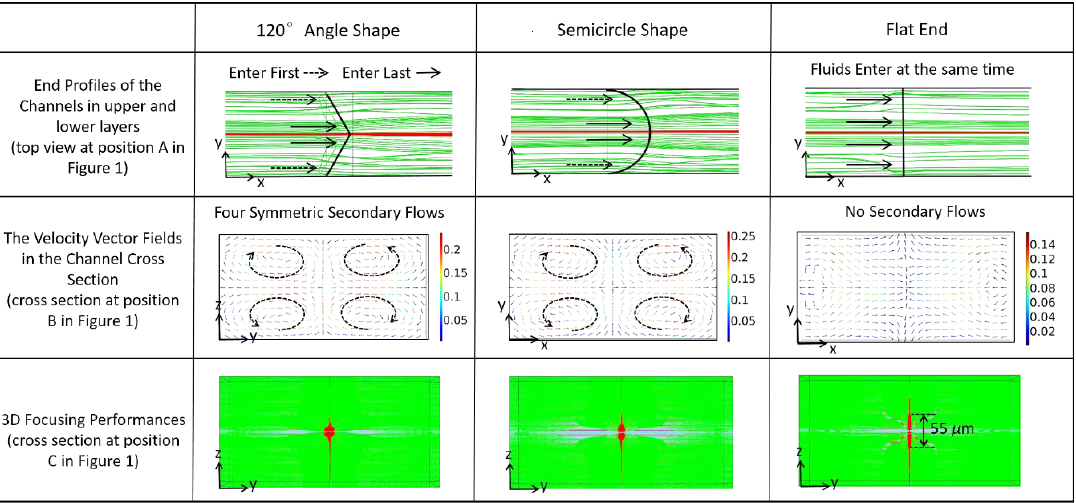
Figure 2. When the end profiles of the channels in the upper and lower layers are designed as convex shapes, secondary flows will intensify the vertical focusing in the straight channel. The simulated results were obtained at Q S = 60 μL/min and Q SH = 7.2 mL/min.